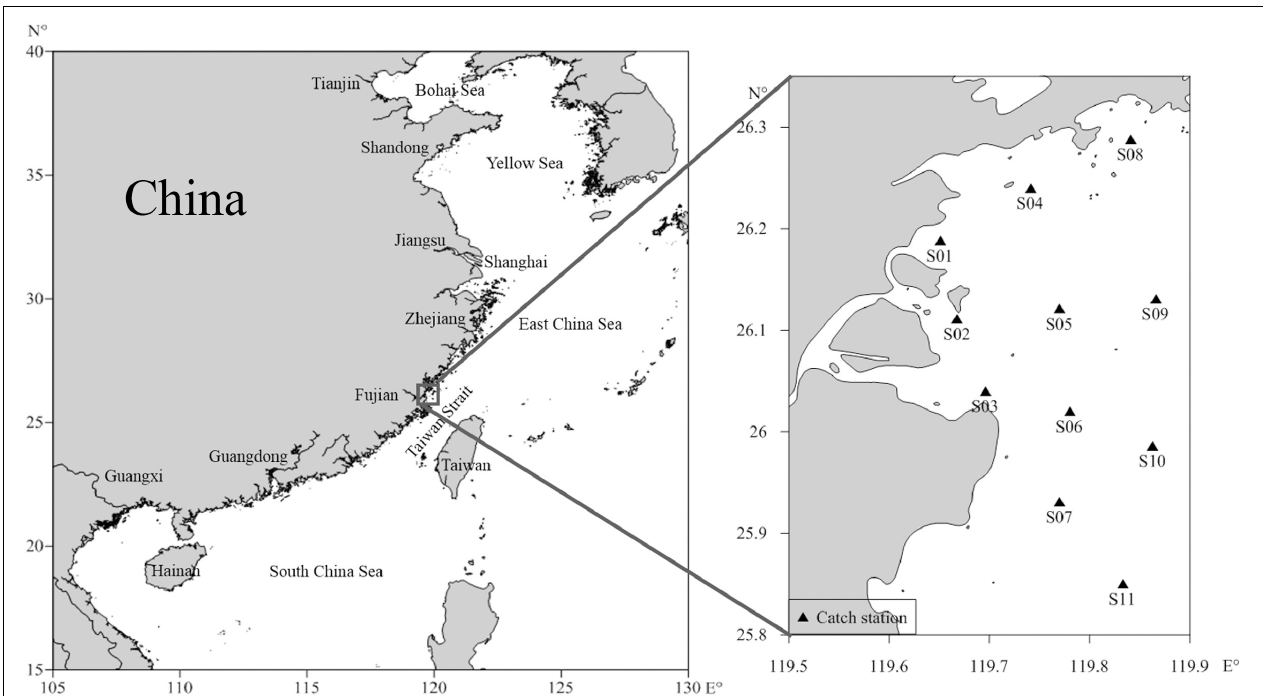
FIGURE 1 | Location of the Min River Estuary and its adjacent waters (left: small square), Fujian Province, China, with the commercial trawl catches from 11 stations (right: S01–S11).